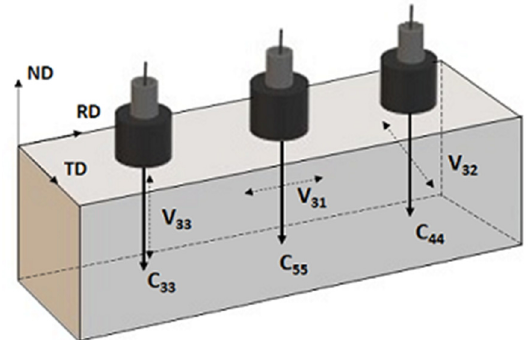
Figure 1. Waves for the determination of elastic constants, with longitudinal and shear waves propagating along ND. The longitudinal wave V 33 is polarized along the ND axis, while the shear waves of velocities V 31 and V 32 are polarized along the RD and TD axes, respectively.